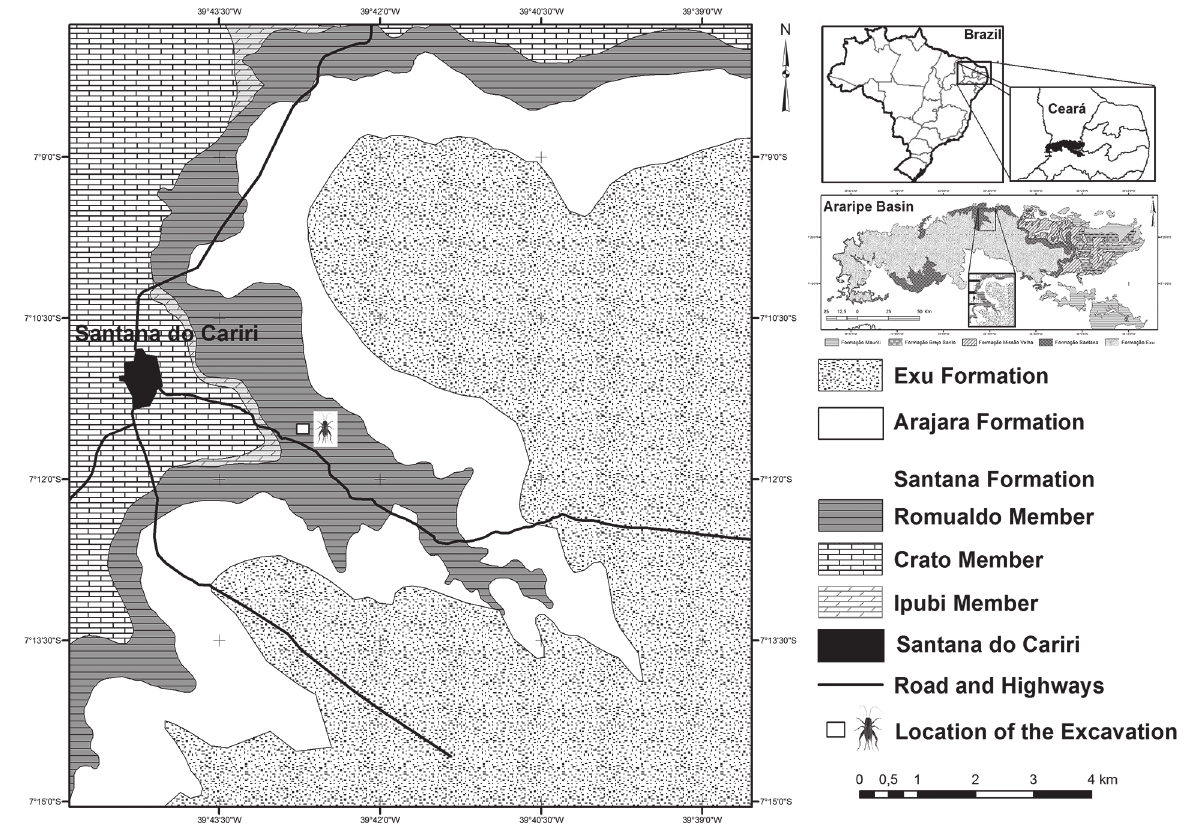
Figure 1 - Map of the location of the Santana do Cariri region within the Araripe sedimentary basin, highlighting the Romualdo Member and the location of the excavations. (Road and Highways – Location of the